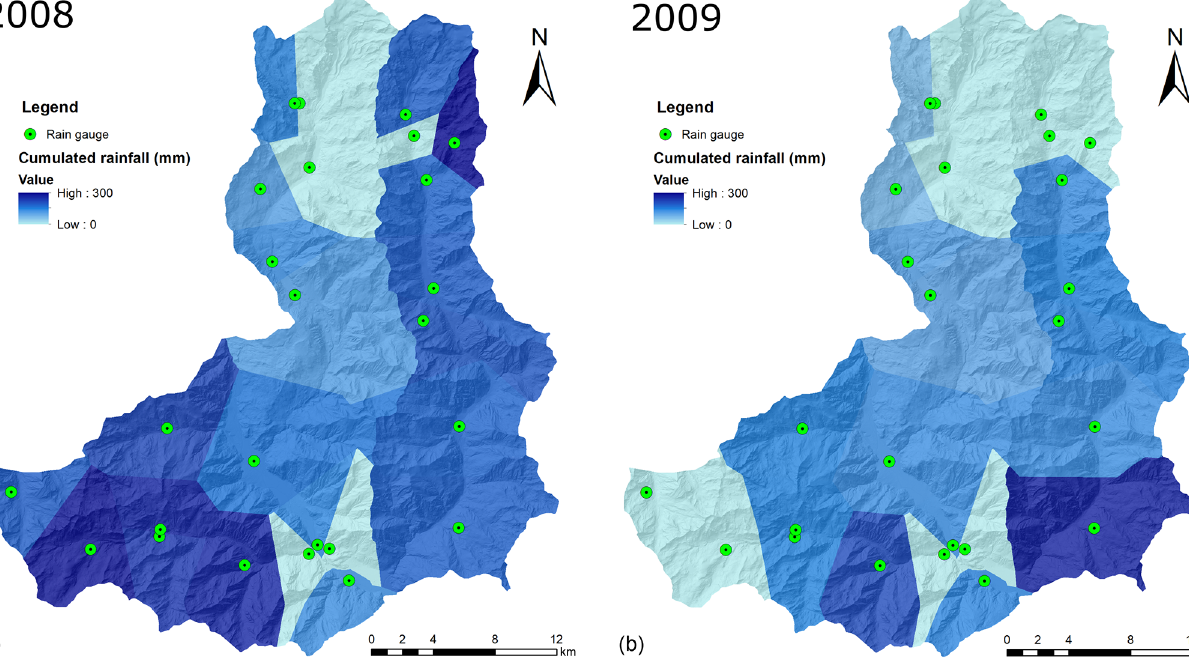
Figure 6. Cumulated rainfall maps for the two